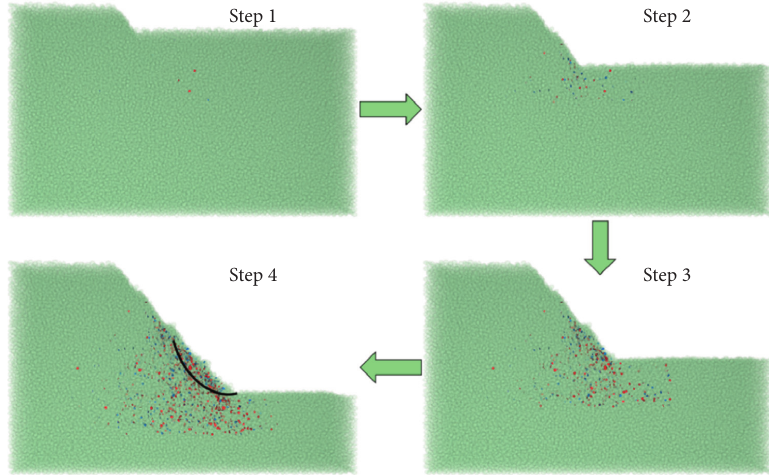
Figure 19: Evolutionary process of microcrack.